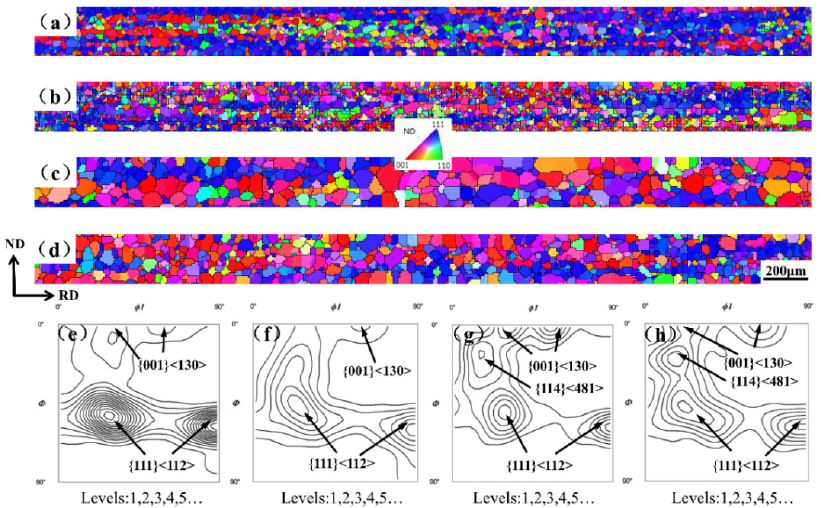
Figure 2. IPF maps, ODF at 𝜑 (cid:2870) = 45° section of final sheets with different Y: ( a , e ) 0Y; ( b , f )